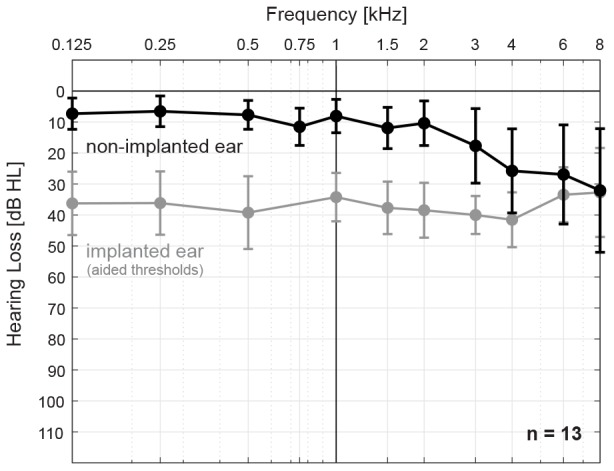
Mean and standard deviation air conduction thresholds for the non-implanted ear, i.e., near-normal hearing (nNH, black) and implanted ear, i.e., cochlear-implant aided thresholds (gray) for all subjects (n = 13).